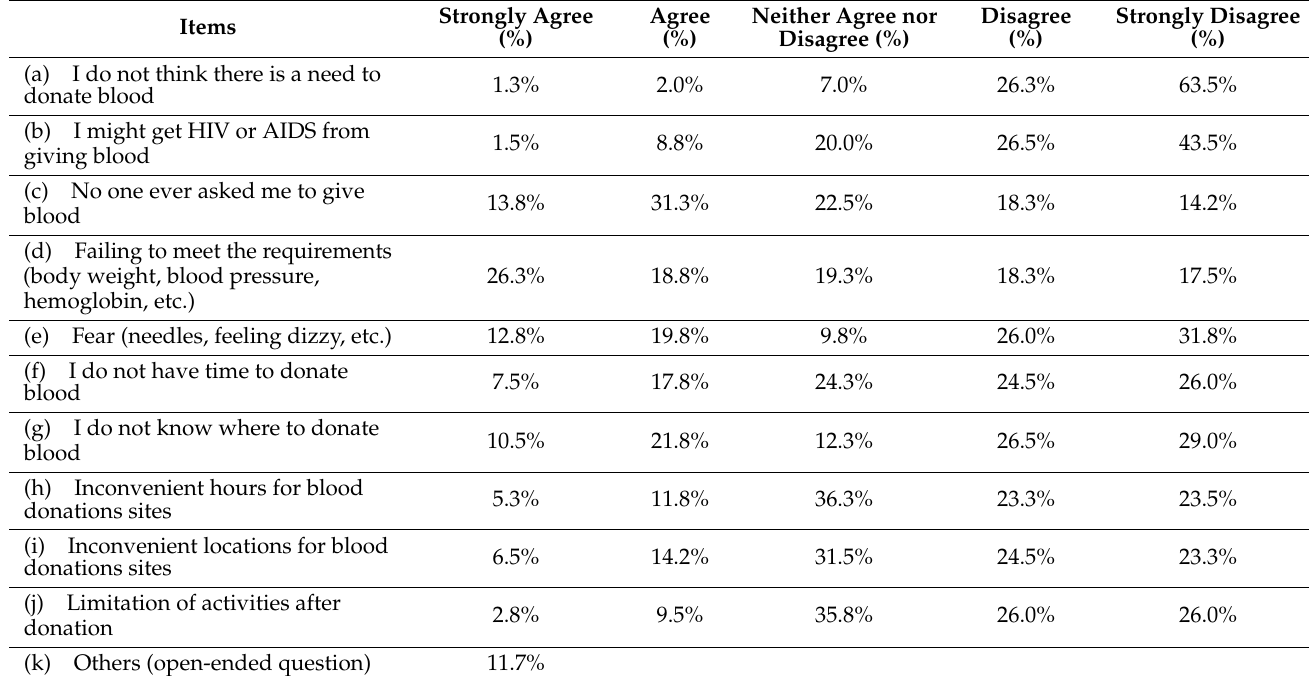
Table 5. Barriers toward blood donation ( N = 400).